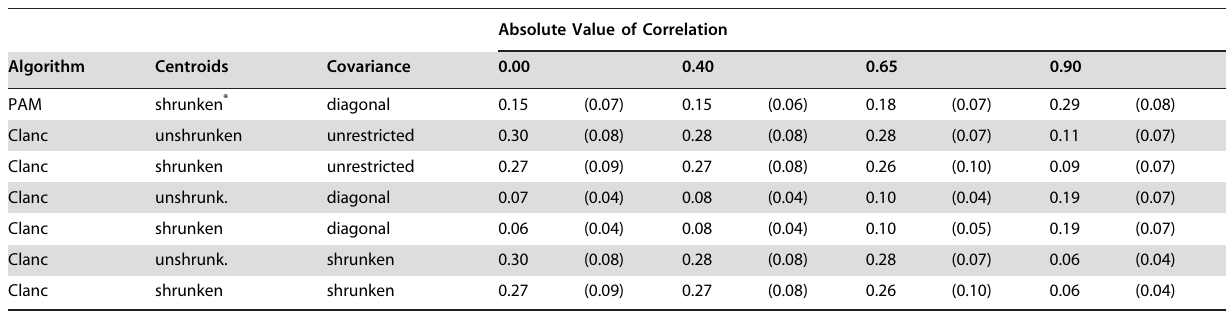
Table 3. Test error rates (standard errors): Classes equidistant. .. ... .... ... ... .... ... ... .... ... ... .... ... ... .... ... ... .... ... ... .... ... ... .... ... ... .... ... ... .... ... ... .... ... ... .... ... ... .... ... ... .... ... ... . Absolute Value of Correlation Algorithm